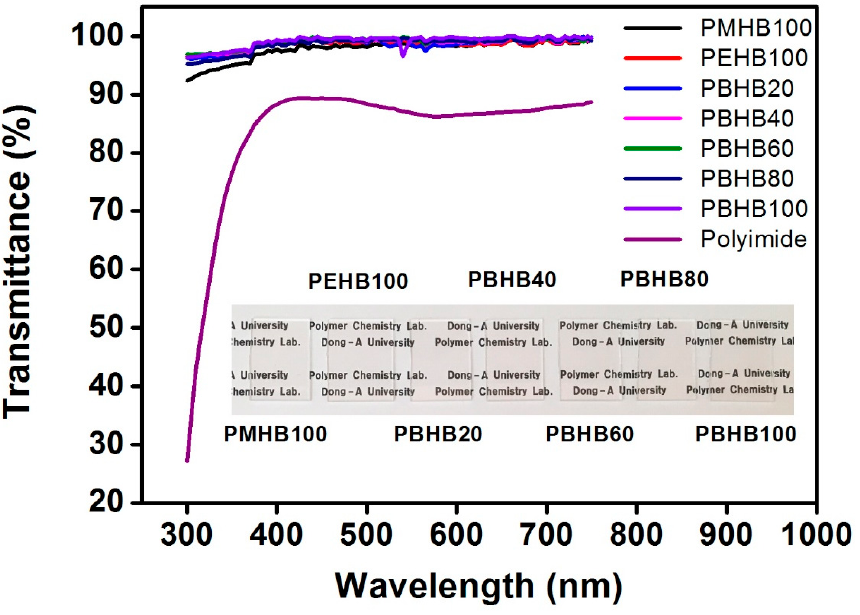
Figure 3. UV-Vis transmittance spectra of PBHB# and PMHB100 and PEHB100 and polyimide alignment layers onto quartz substrates.